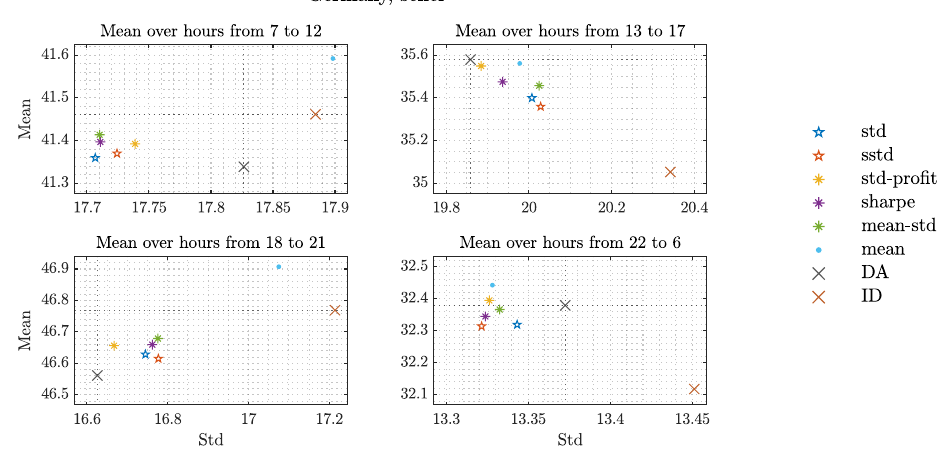
Figure 7. Average results of the portfolio allocation, ( σ h , t , E [ s h , t ]) obtained for a seller in the German market using different strategies. The averages are calculated over all days in the validation window and hours within the considered blocks: 7–12, 13–17, 18–21, 22–6. The results of trading only on the day-ahead (DA) or intraday (ID) market are plotted for reference. Source: Authors’ elaboration.